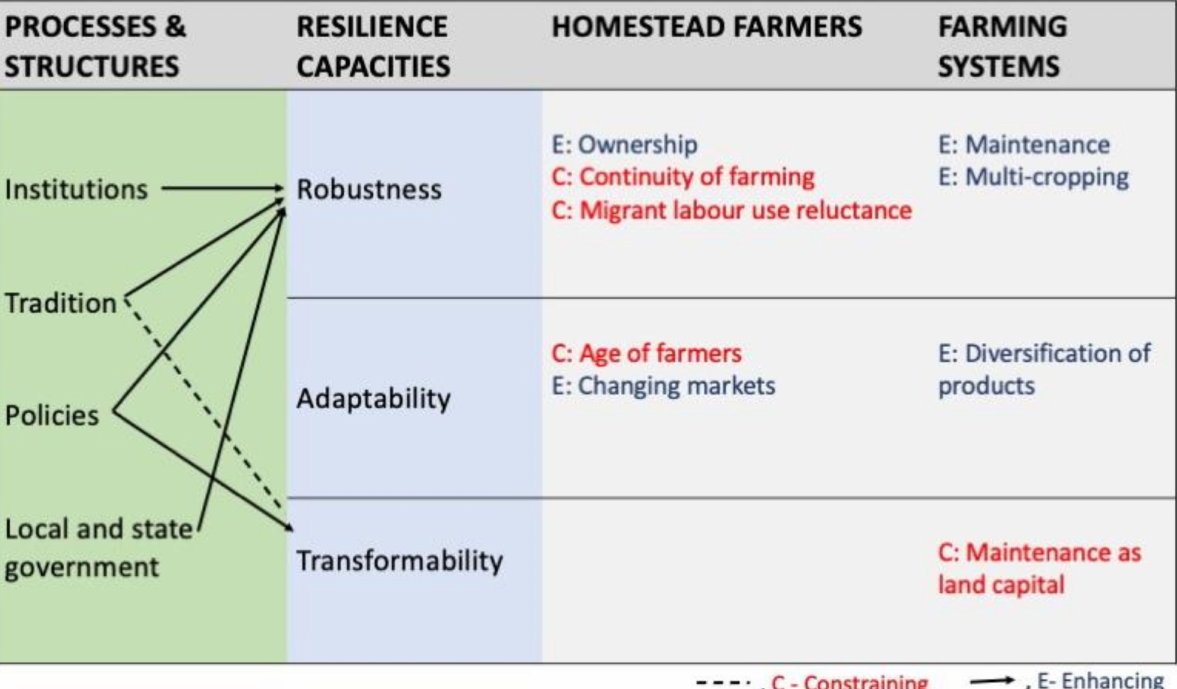
Figure 5. Resilience capacities, processes, and structures of homestead